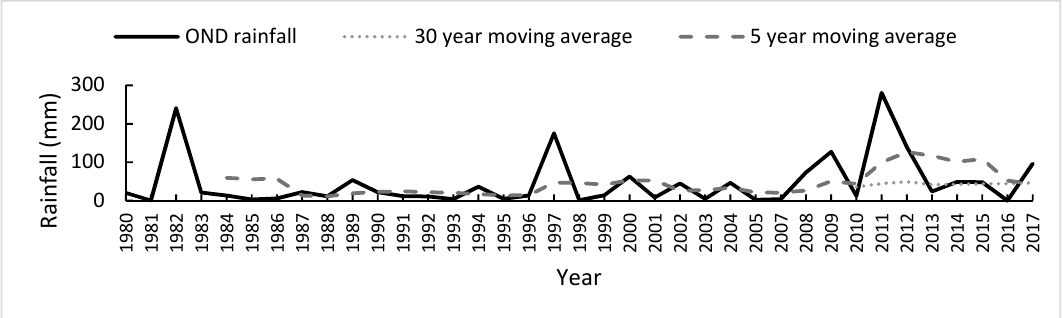
Figure 2. Total annual rainfall in Turkana (source: Kenya Meteorological Department, Lodwar meteorological station record).